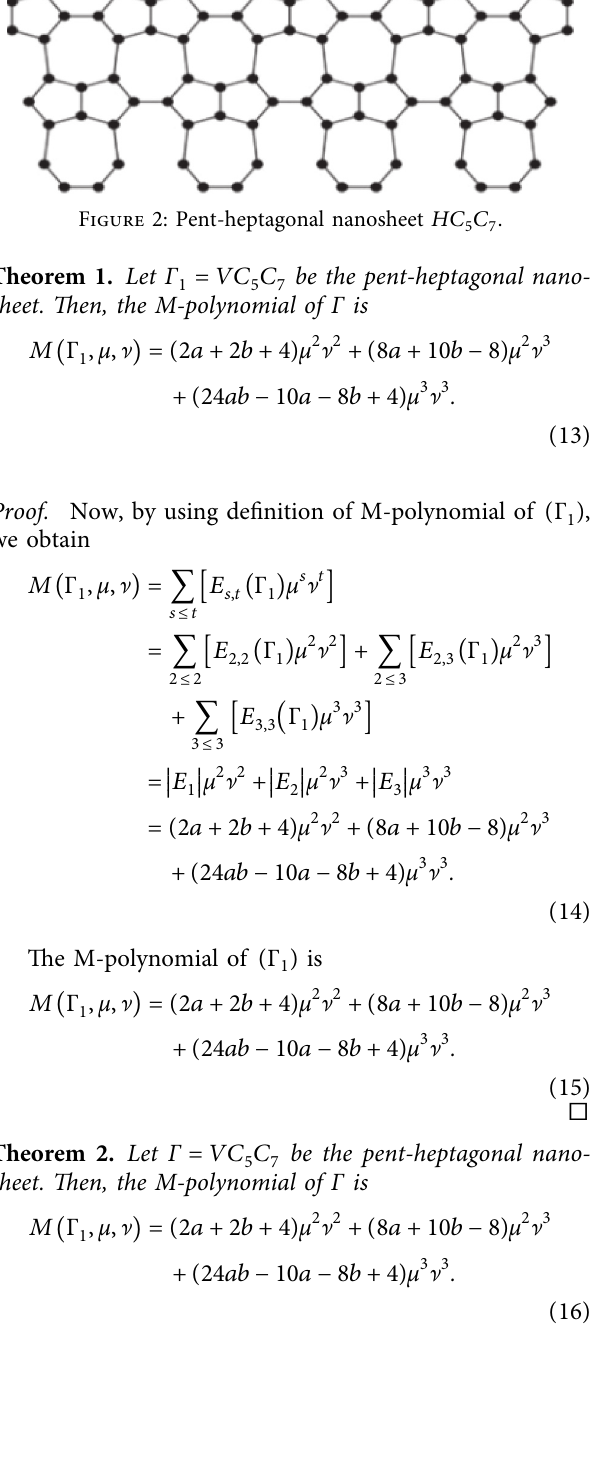
Table 4: Partition of edge set of HC